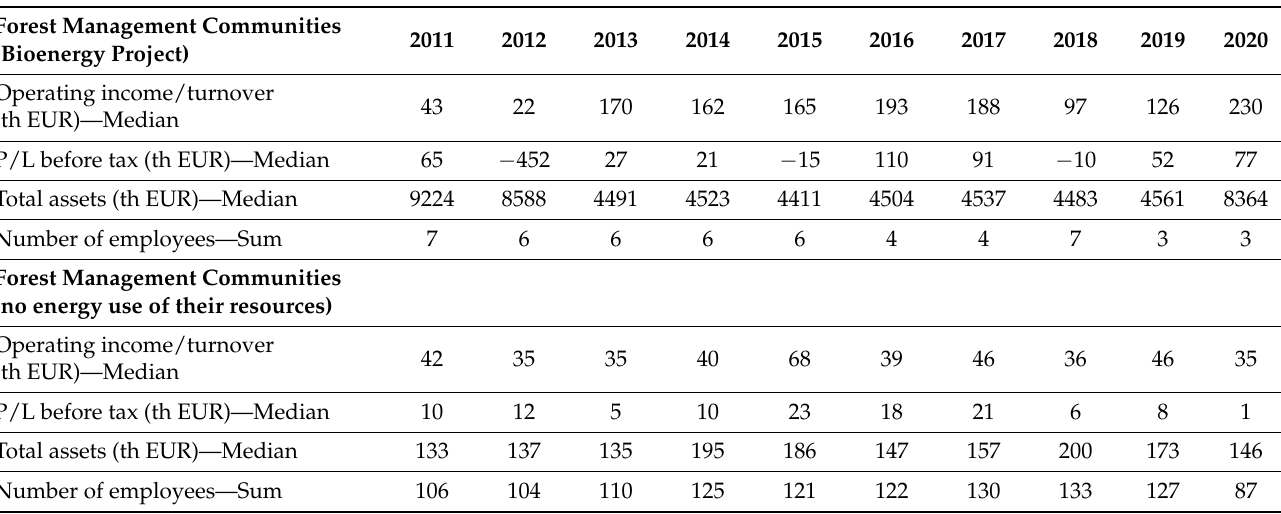
Table 2. Structure indicators of the two groups of forest management communities at the aggre- gate level.